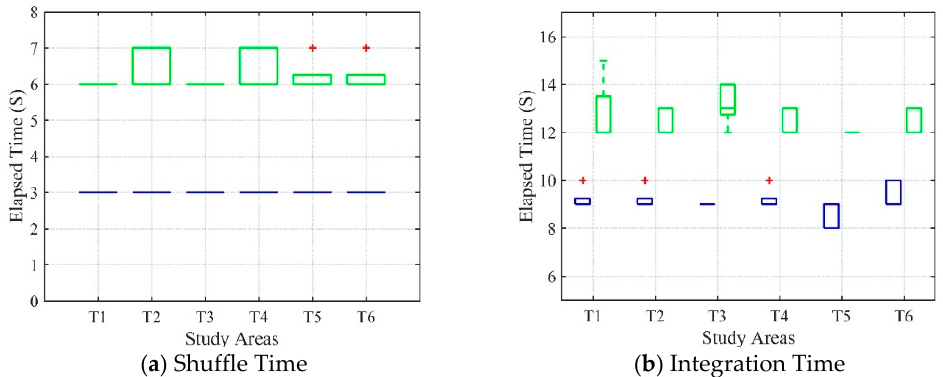
Figure 11. Execution time of the shuffle and integration stage of S1 and S2 for T1 to T6 using the SLIC algorithm with eight executors, while the S1 and S2 are separately in blue and green. The red plus indicates the outliers. Table 7. The data volume variations during in different processing